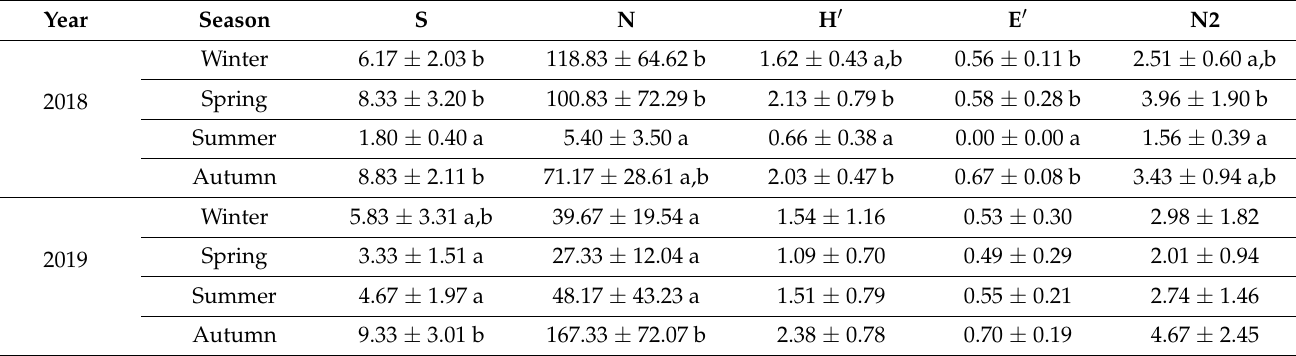
Table 7. Mean values with their respective standard deviation for Species richness (S), Species abundance (N) Shannon–Wiener diversity index (H (cid:48) ), Corrected Evenness (E (cid:48) ), and Hill’s Index (N2) for the floristic composition of QV